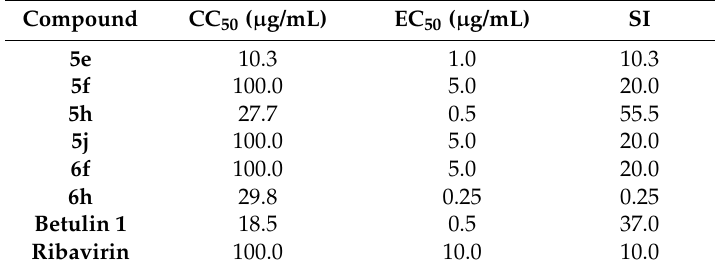
Table 2. Antiviral activity of betulin derivatives against the cytopathogenic bovine orphan virus (ECBO) strain LCR-4 in adenocarcinoma epithelial (A549)